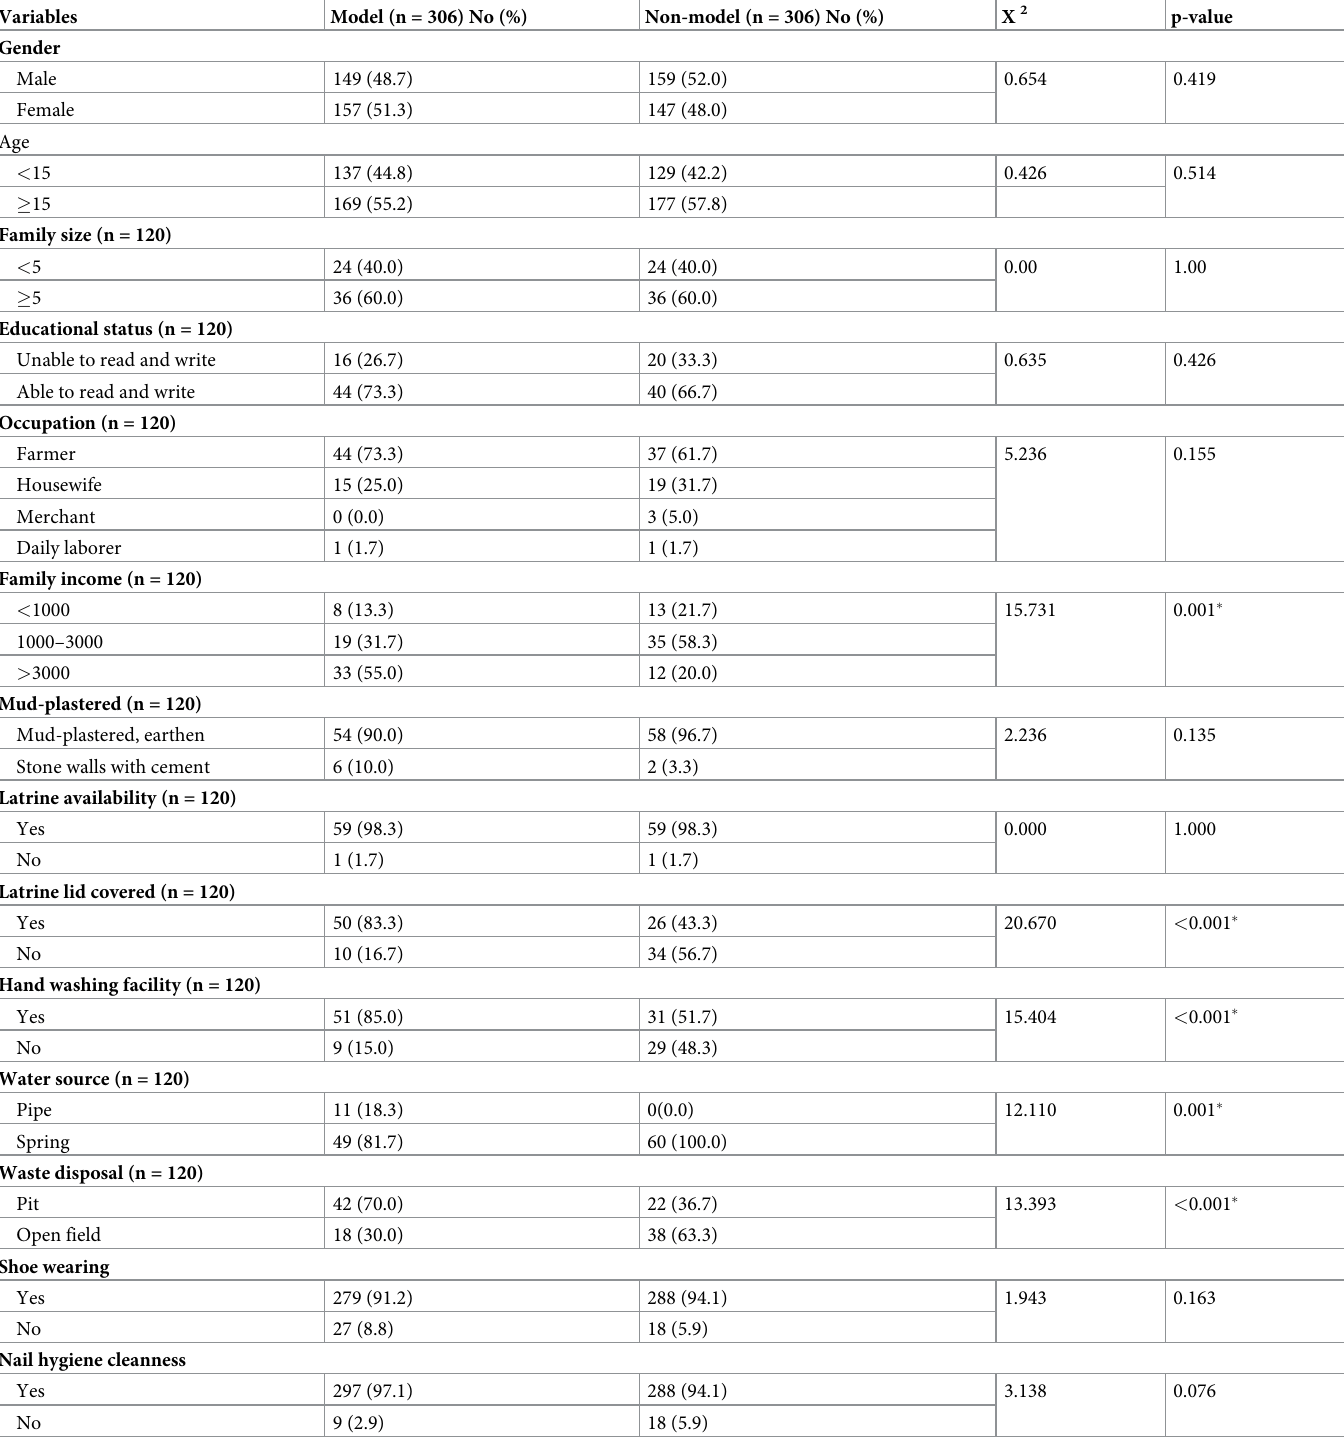
Table 1. Socio-demographic, socio-economic and hygiene conditions among individuals in model & non-model HHs, Seka Chekorsa woreda, Jimma, Southwest